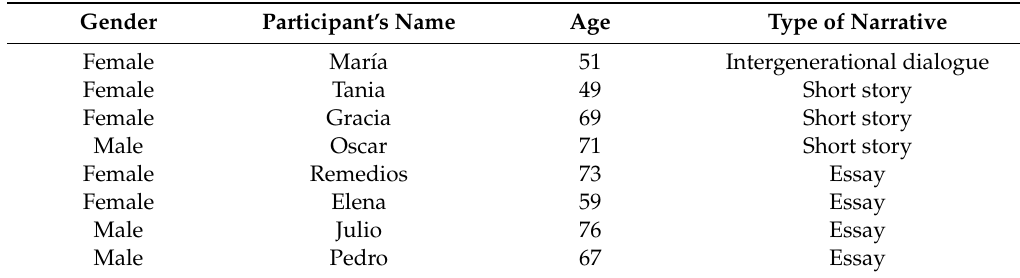
Table 1. Participant